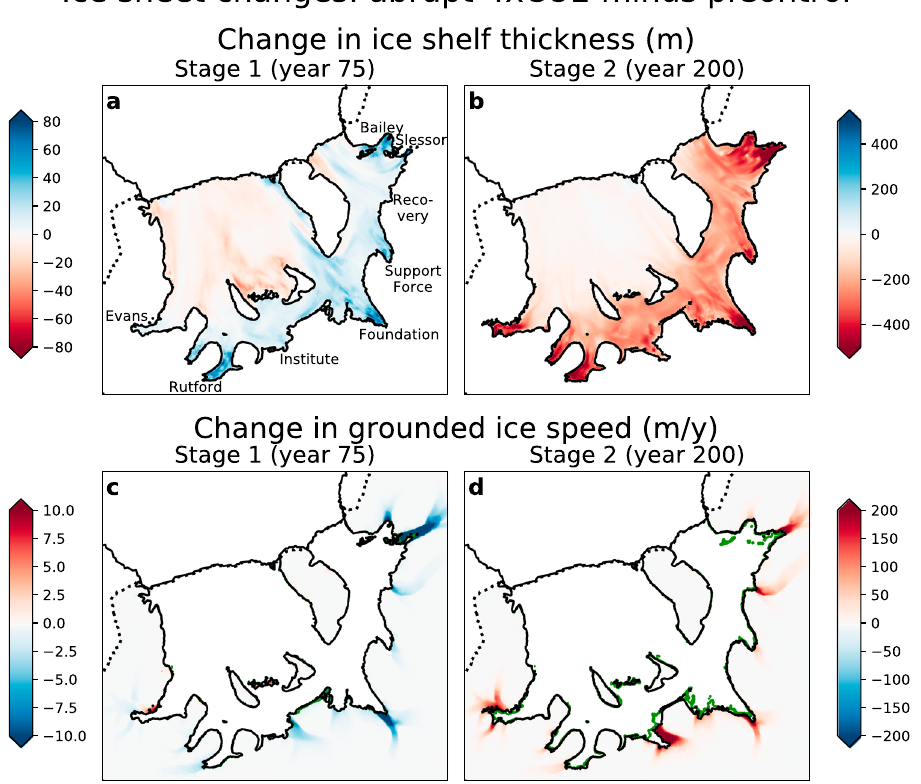
Fig. 7 Changes in ice sheet properties during the abrupt-4xCO2 simulation and 50-year extension. a Ice shelf thickness anomaly (m) after 75 years; b after 200 years. c Grounded ice speed anomaly (m/y) after 75 years; d after 200 years. Note the differing colour scales for the two time periods. Model drift is removed by subtracting the piControl simulation at the same point in time. Black grounding lines are from the abrupt-4xCO2 simulation, while the green contours in ( c ) and ( d ) show the piControl grounding lines for comparison. Pinning points in the Filchner Ice Shelf appear as isolated green points. Black labels in ( a ) denote geographical features: the Bailey, Foundation, Institute, Rutford, and Evans Ice Streams; and Slessor, Recovery, and Support Force